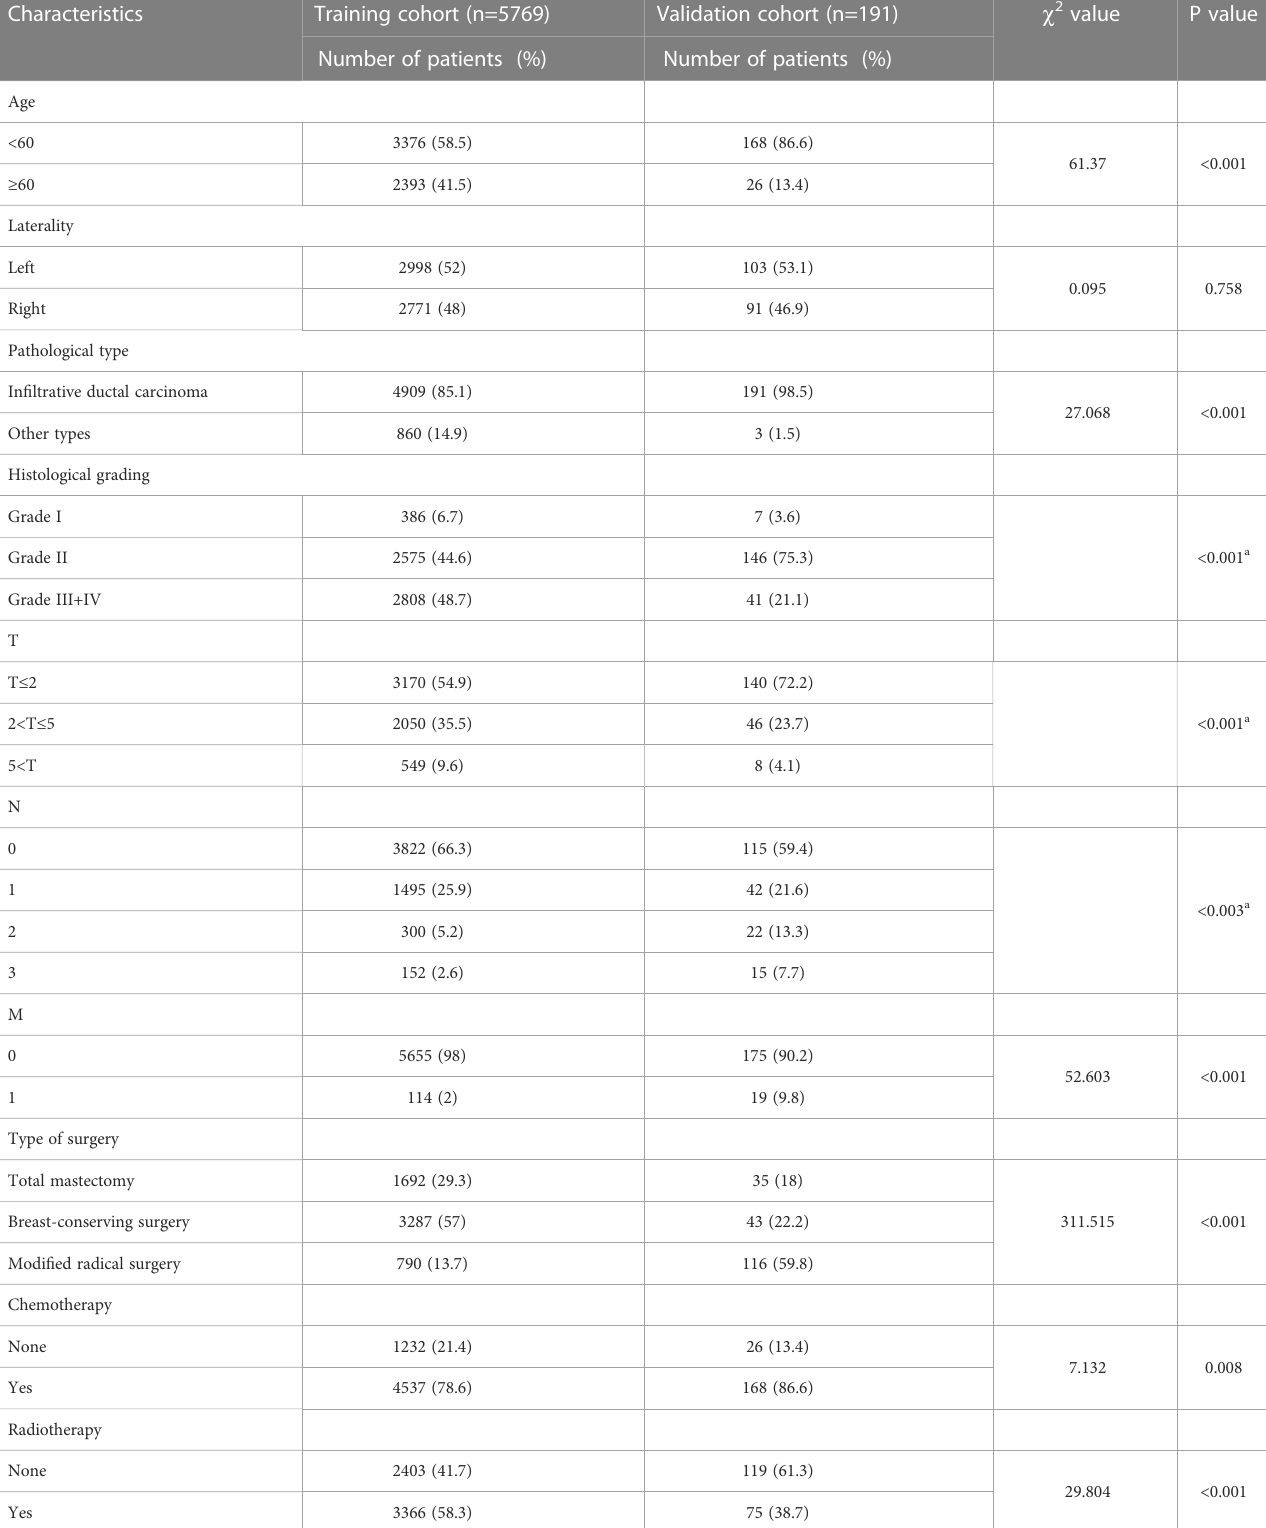
TABLE 1 Baseline characteristics of TPBC